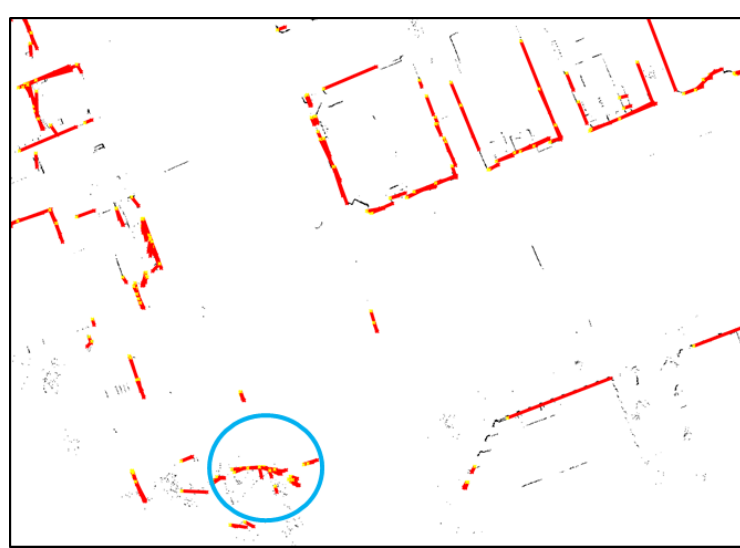
Figure 17. Line extraction result for vertical structures (incorrectly detected lines in a blue circle).